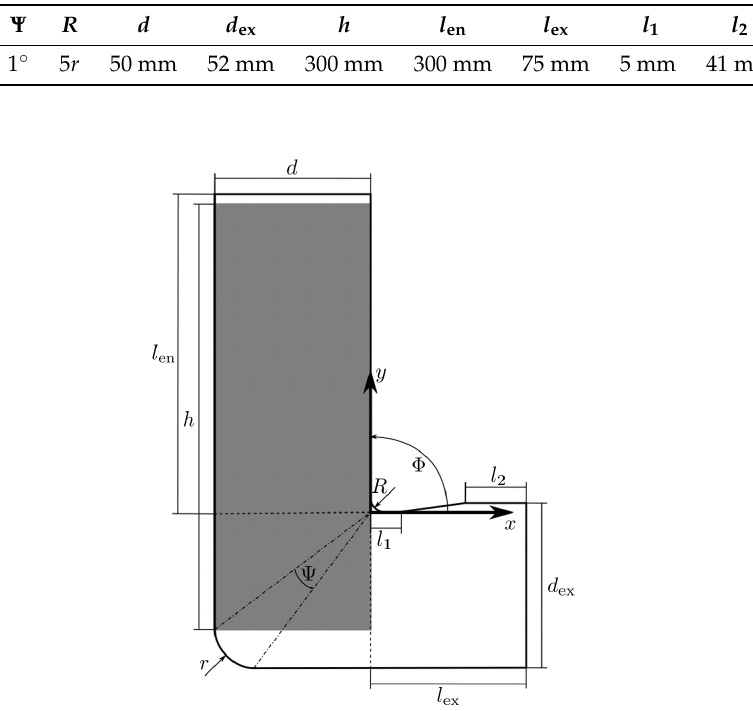
Table 1. Geometry parameters for the simulation model (cf. Figure 2).